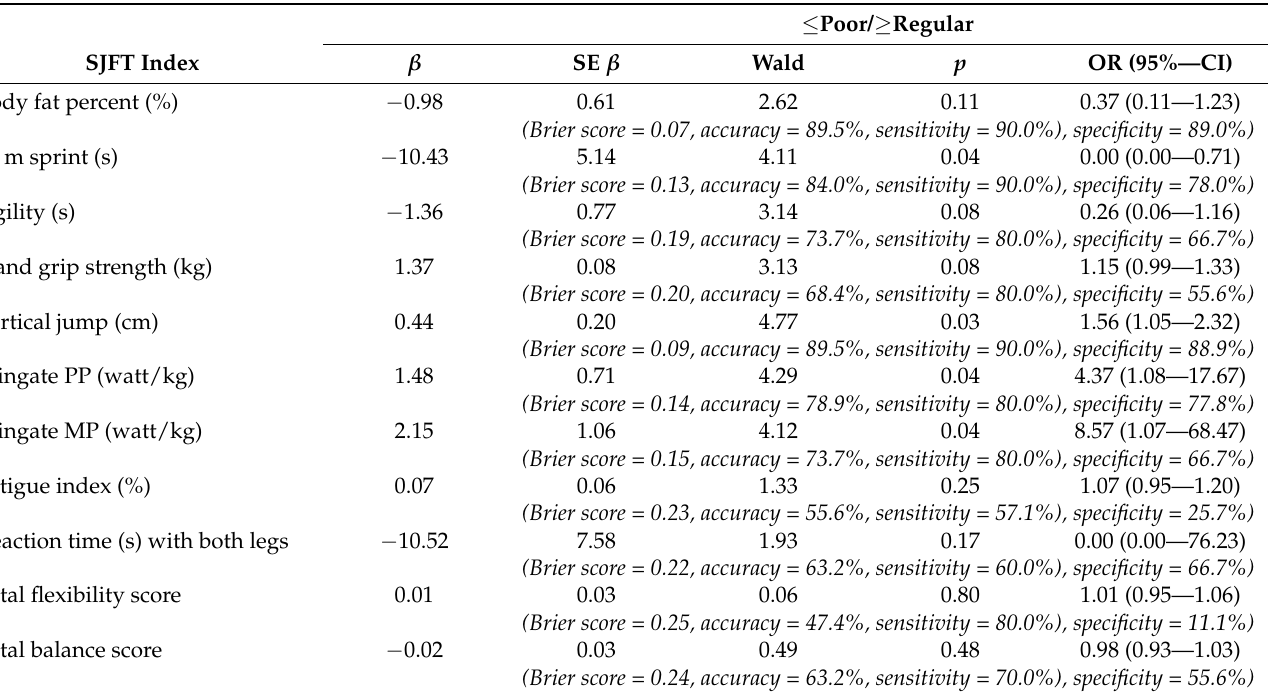
Table 2. Results from simple logistic regression model for the SJFT index classificatory table ( ≤ Poor/ ≥ Regular), showing Odds Ratios (OR) and their 95% confidence intervals (Cl), regression coefficients ( β ), and their standard errors